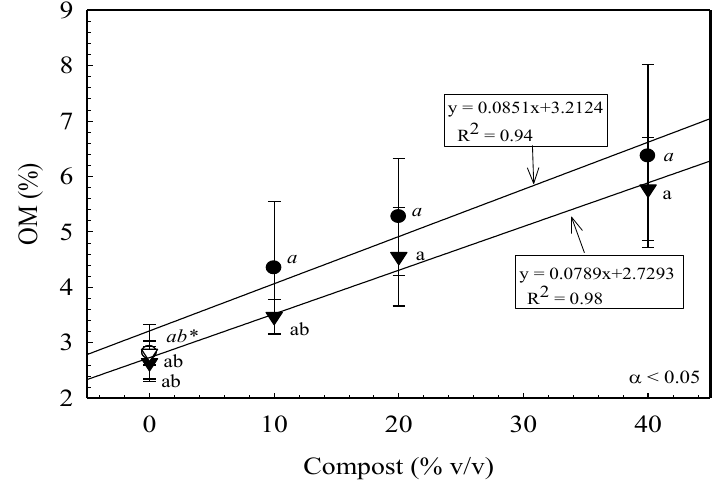
Figure 2. Effect of incorporating composted poultry litter into top 12.7 cm of subsoil on organic matter for ● sodded compost; ○ sodded fertilizer; ▼ seeded compost; and seeded fertilizer plots; * Means with same letters are statistically insignificant based on Fisher’s Protected LSD test ( P ≤ 0.05) (italicized statistics correspond to sodded treatments).